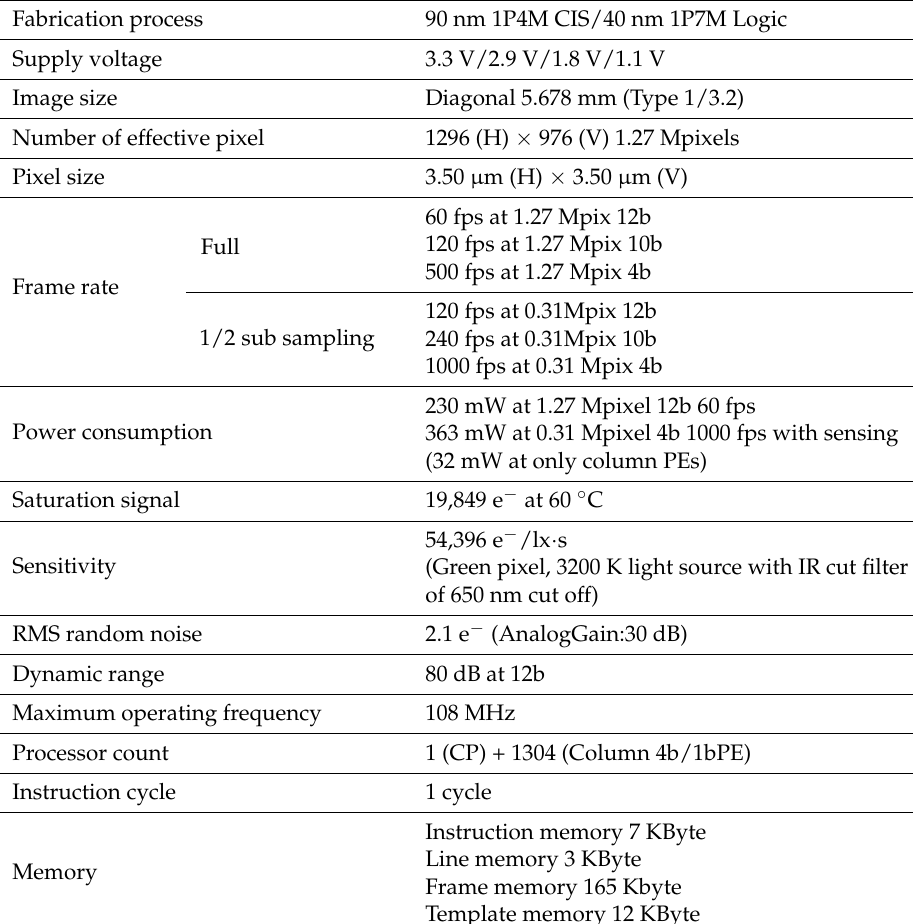
Table 3. Chip specifications.